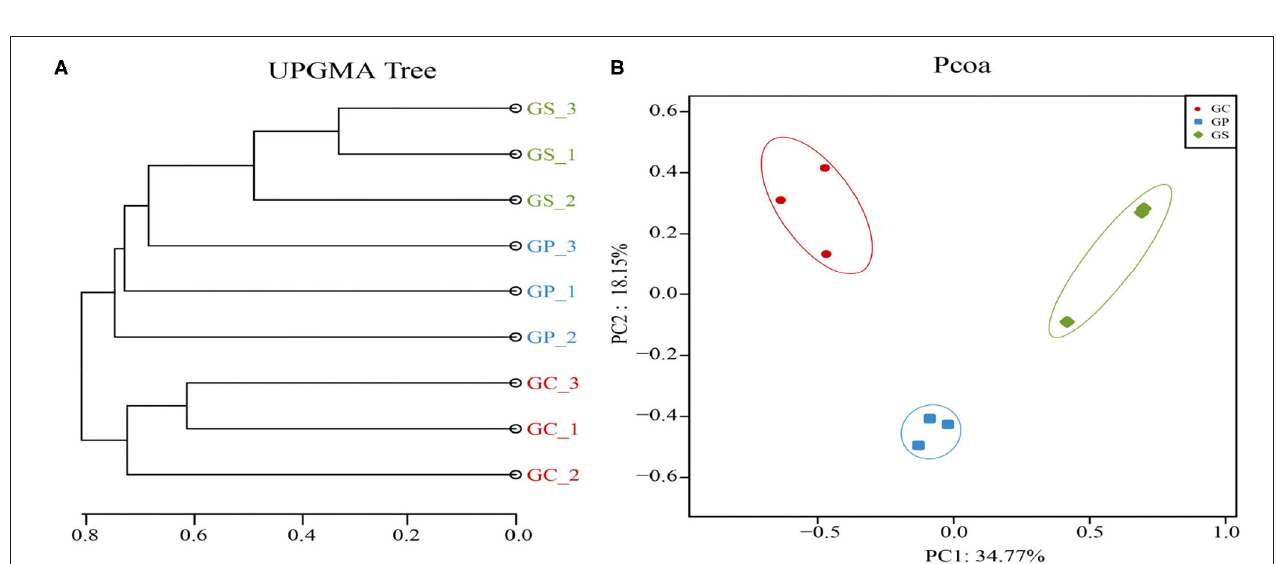
FIGURE 2 | The differences in the composition of ARGs during the GP processing. (A) UPGMA cluster analysis of ARG abundance in three garlic products. (B) PCA based on Bray–Curtis distance showed the overall distribution pattern of ARGs during GP processing.